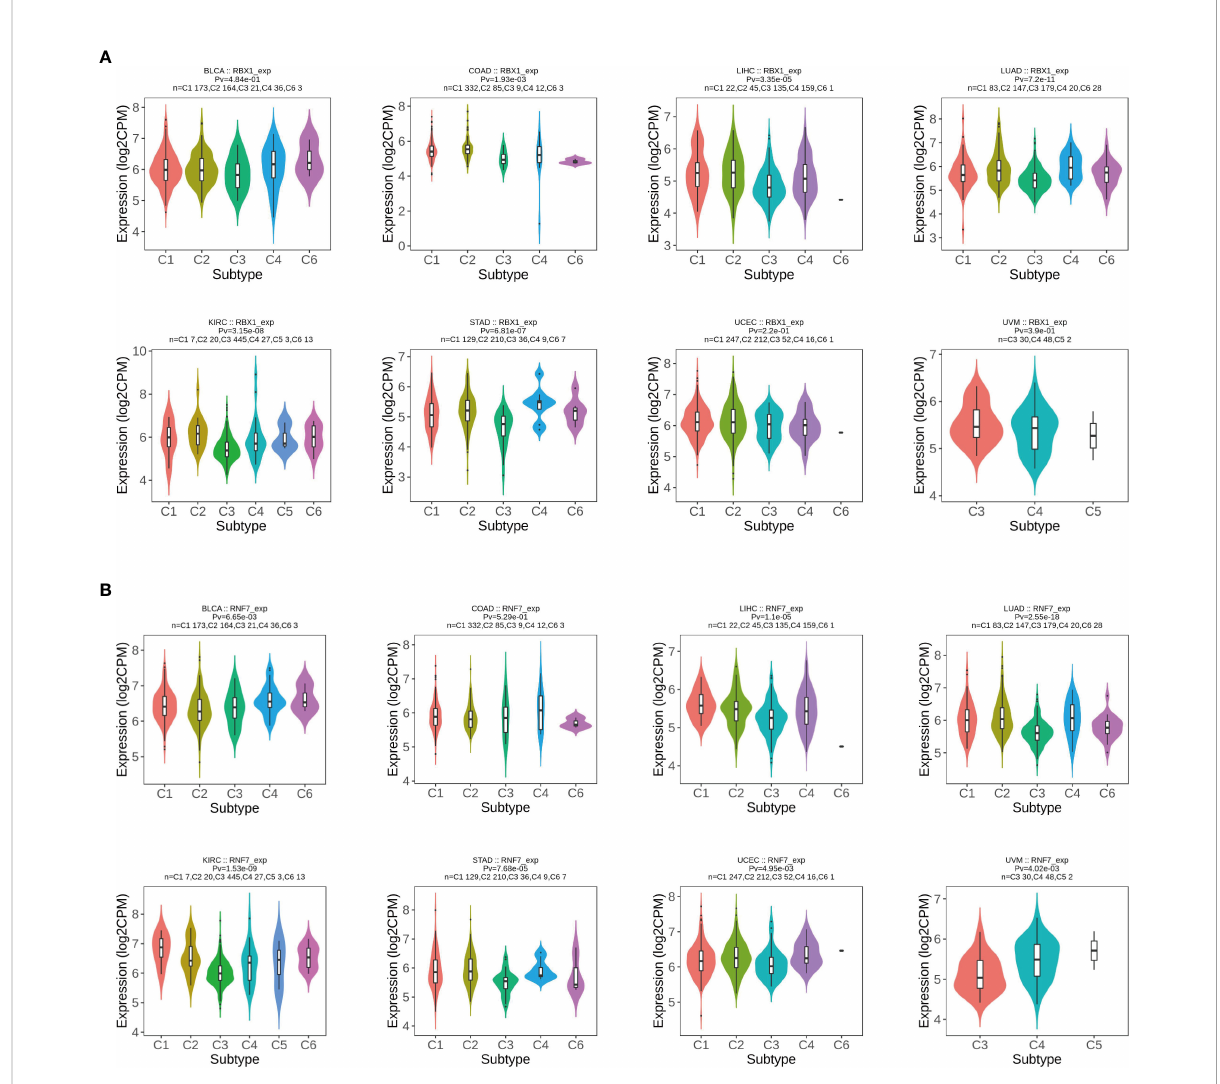
FIGURE 6 The relationship between RBX1/2 expression and pan-cancer immune subtypes. (A) Correlation of RBX1 expression and immune subtypes in BRCA, COAD, LIHC, LUAD, KIRC, STAD, UCEC and UVM. (B) Correlation of RBX2 expression and immune subtypes in BRCA, COAD, LIHC, LUAD, KIRC, STAD, UCEC and UVM. P value less than 0.05 is considered as